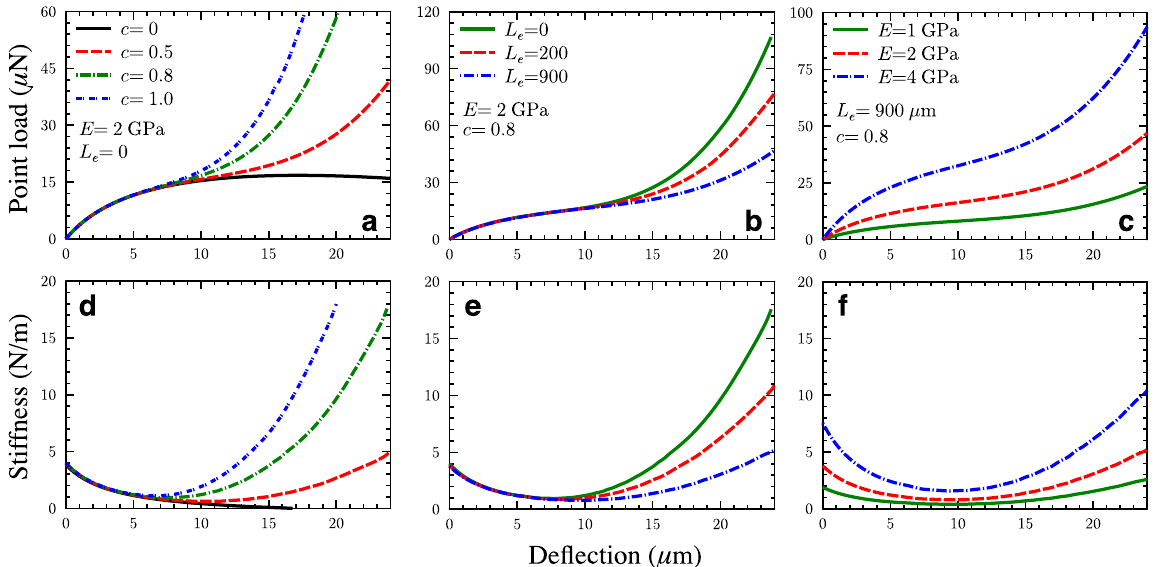
Figure 2. The influence of model parameters on the point-load vs. deflection curves (top row) and point- stiffness vs. deflection curves (bottom row) for the BM without a soft TBC layer (using the model version in Fig. 1c). ( a,d ) Effects of varying the volume-dispersal factor c . ( b,e ) Effects of varying the axial stiffness parameter L e ( L e determines the in-plane stiffness k a of the AZ and PSL). ( c,f ) Effects of varying the BM collagen-fiber elastic modulus